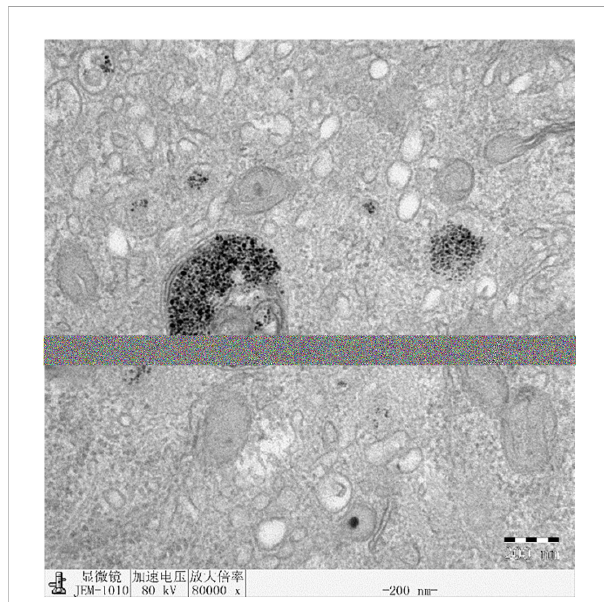
FIGURE 12 TEM of HepG2 cell containing Fe 3 O 4